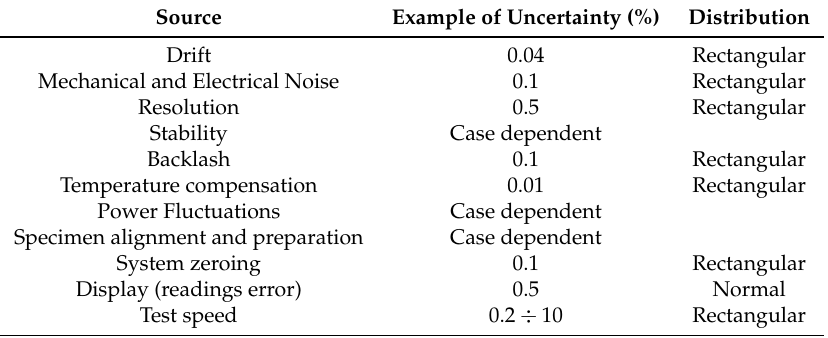
Table 8. Examples of the main contributions to uncertainty in testing machine during use [93]. Source Example of Uncertainty (%) Distribution Drift 0.04